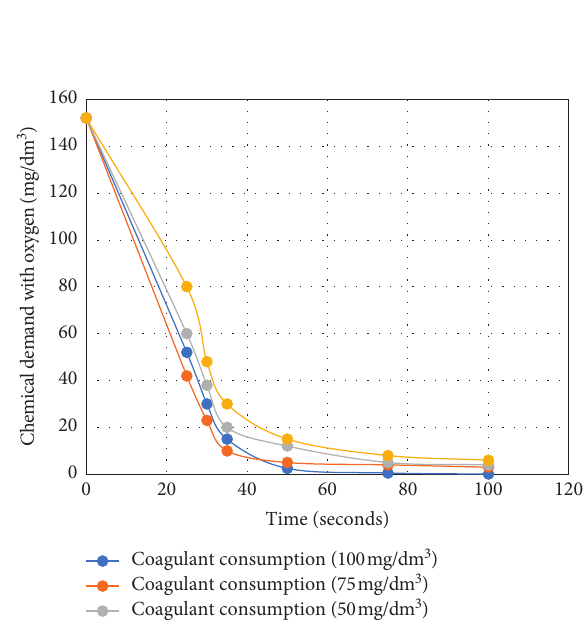
Figure 1: Dependence of chemical demand for oxygen for sewage waters in the duration of interaction with coagulant.